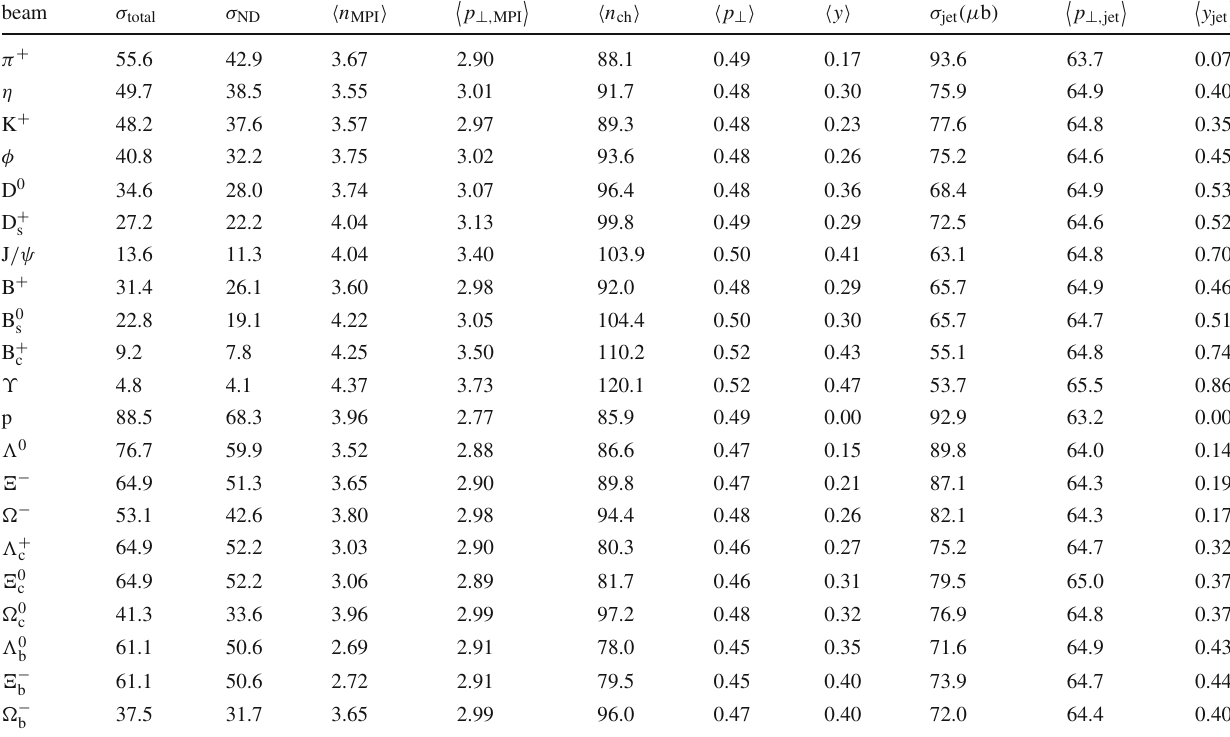
Table 4 Some basic numbers for various non-diffractive hadron– proton collisions at 6 TeV: total and nondiffractive cross sections (in mb); average number and p ⊥ of MPIs in nondiffractive events; average